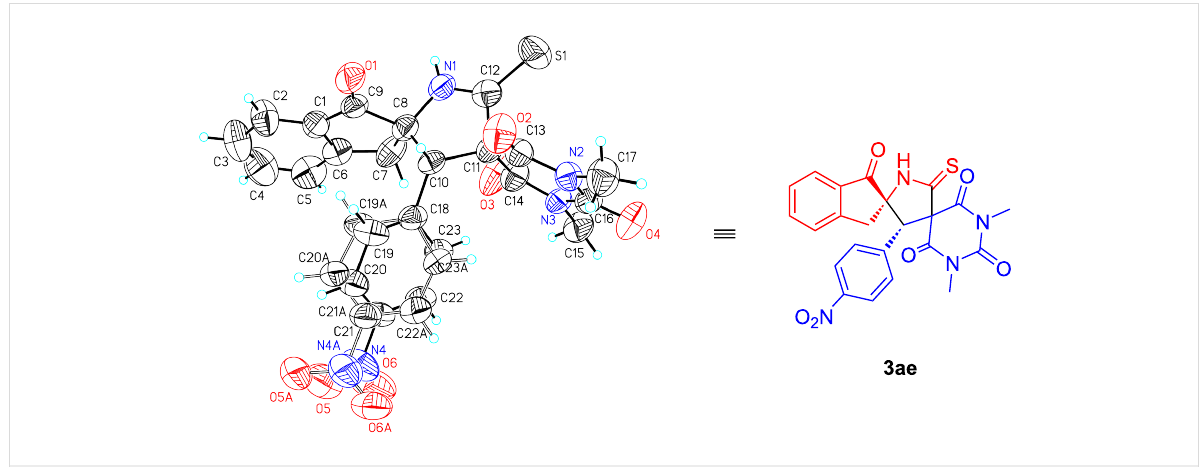
Figure 4: X-ray crystal structure of 3ae (displacement ellipsoids are drawn at the 50% probability level).